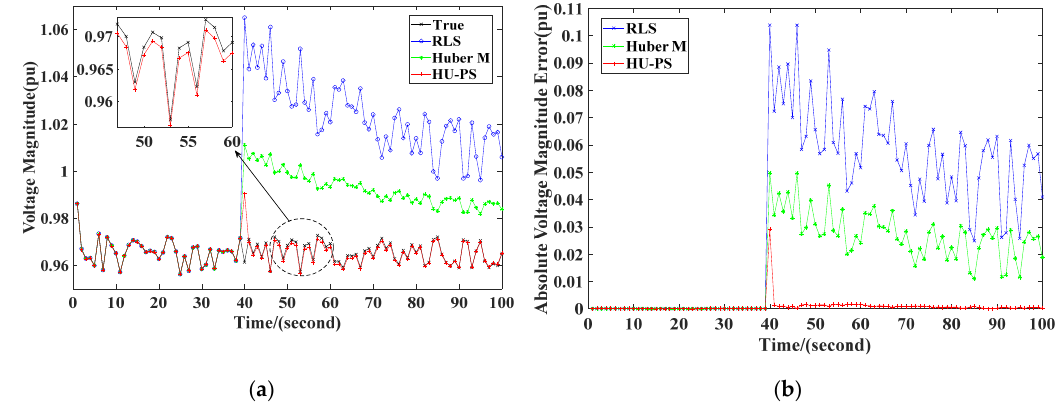
Figure 6. Values in scenario 2: ( a ) voltage magnitude, ( b ) absolute voltage magnitude error.